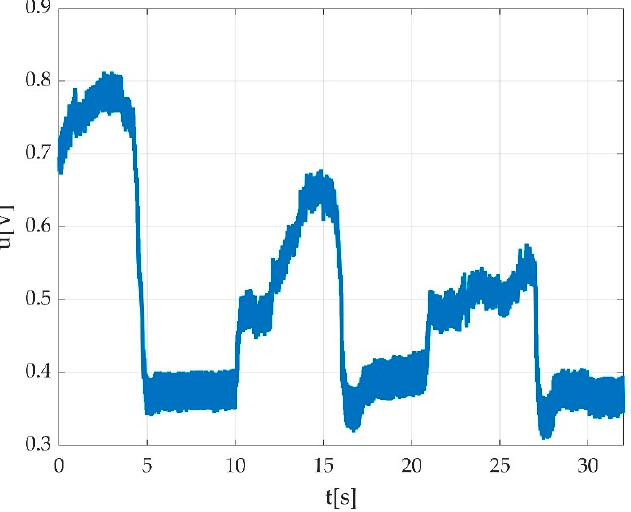
Figure 20. Example of invalid measurement due to participant inability to complete a maximal mus-